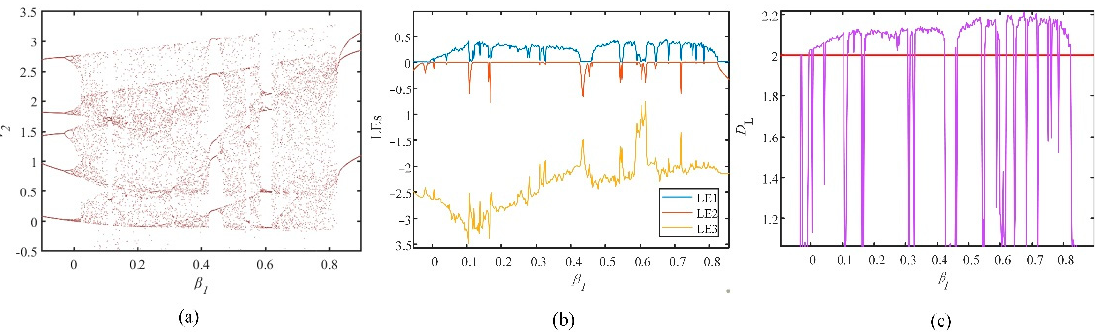
Figure 5. Synaptic weight β 1 ∈ (0,0.8), q = 0.8, β 2 = 12. ( a ) Bifurcation diagram; ( b ) Lyapunov exponents spectrum; ( c ) Lyapunov dimension.